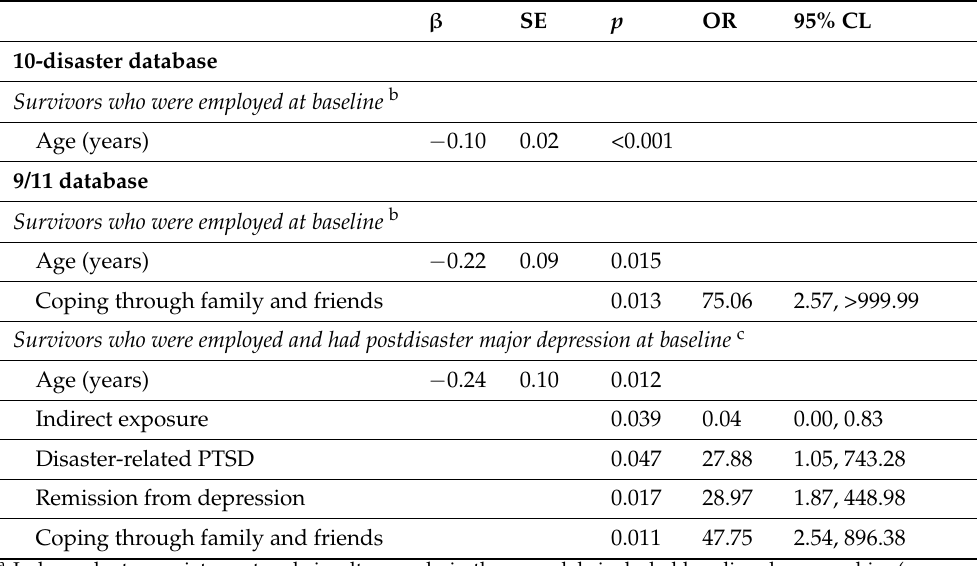
Table 2. Multivariate models predicting current employment at follow up in two databases a . β